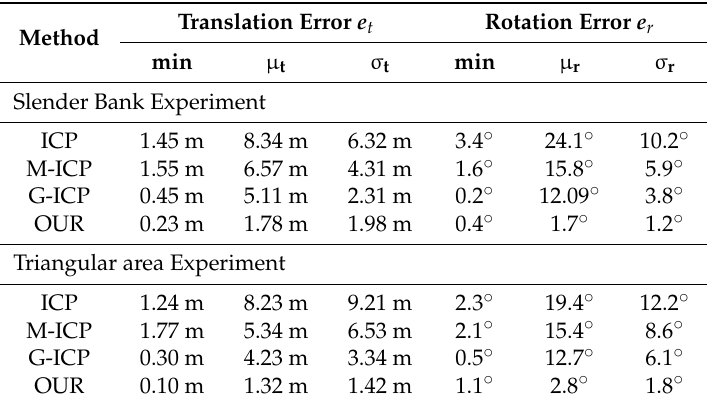
Table 2. Registration results with a normal initial error.